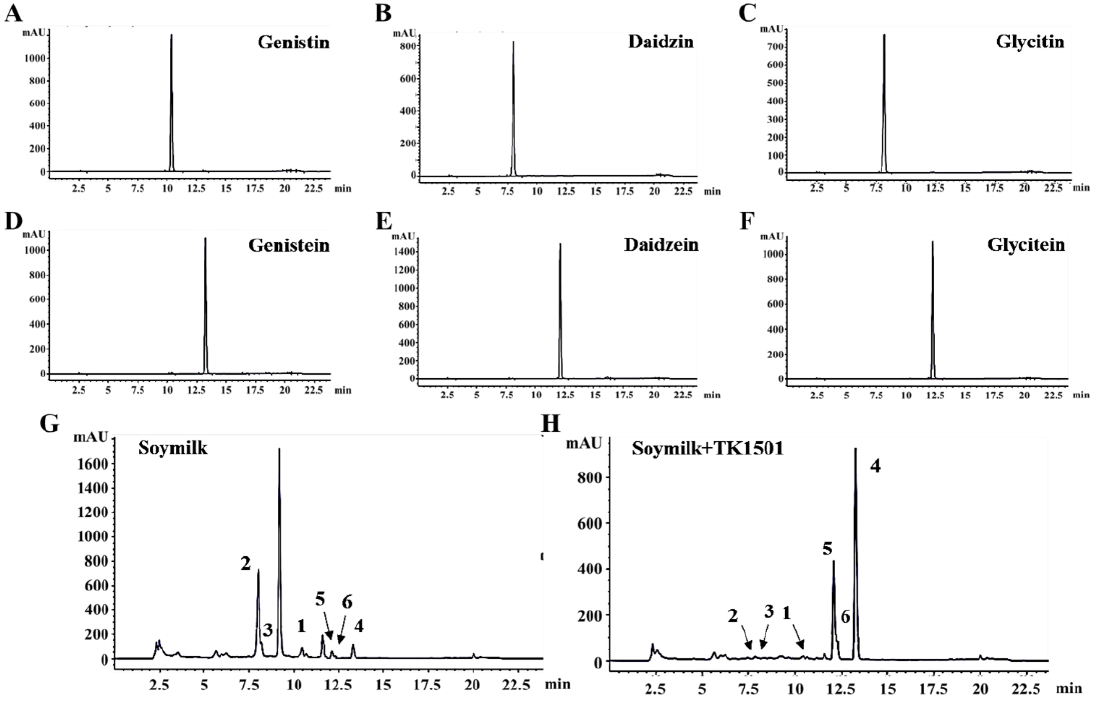
Table 4. The degradation rate of isoflavones in the L. paracasei TK1501 fermented soymilk.